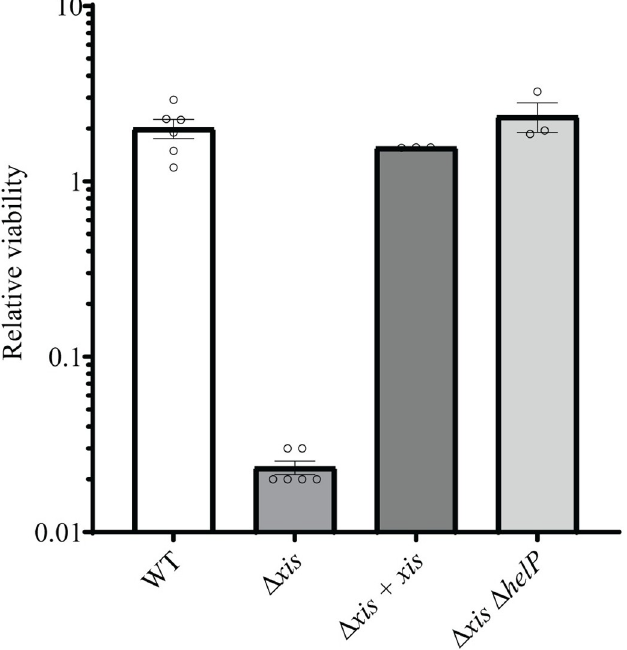
Fig 3. Activation of ICE Bs1 that is unable to excise from the chromosome causes loss of cell viability. Cells were grown at 37˚C in a defined minimal medium containing L-arabinose as a carbon source. Expression of rapI (P xyl-rapI ) was induced by the addition of D-xylose for 60 mins. Viability was determined by CFUs and normalized to the number of CFUs at the time of induction (addition of xylose). ICE Bs1 WT = AB77; ICE Bs1 Δ xis = SAM249; ICE Bs1 Δ xis + xis (i.e., complementation of Δ xis ) = SAM388; ICE Bs1 Δ xis Δ helP (unable to undergo autonomous rolling circle replication) = SAM393. Results are the means from at least 3 biological replicates each with two technical replicates for CFU counts. Error bars indicate standard error of the